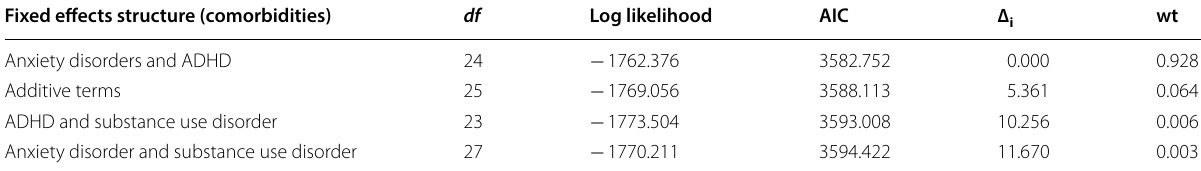
Table 3 Multi-model inference indicating that the model incorporating two interactions terms best describes the data Fixed effects structure (comorbidities)